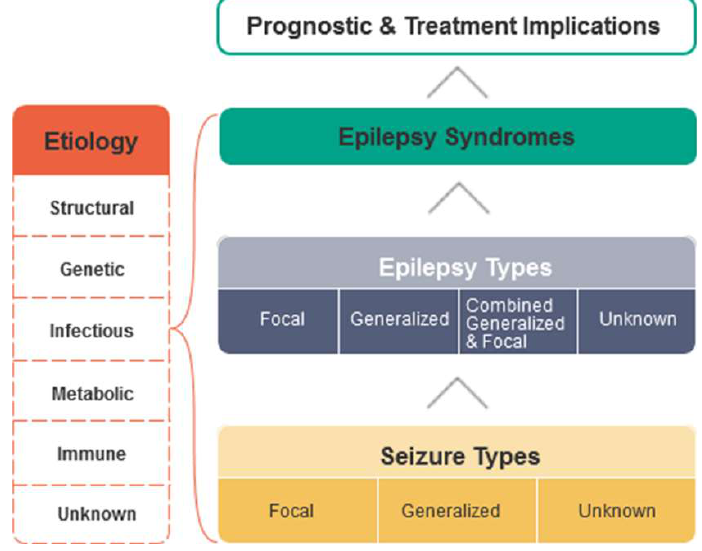
Figure 1. Recommendation of epilepsy and epilepsy syndromes by ILAE.